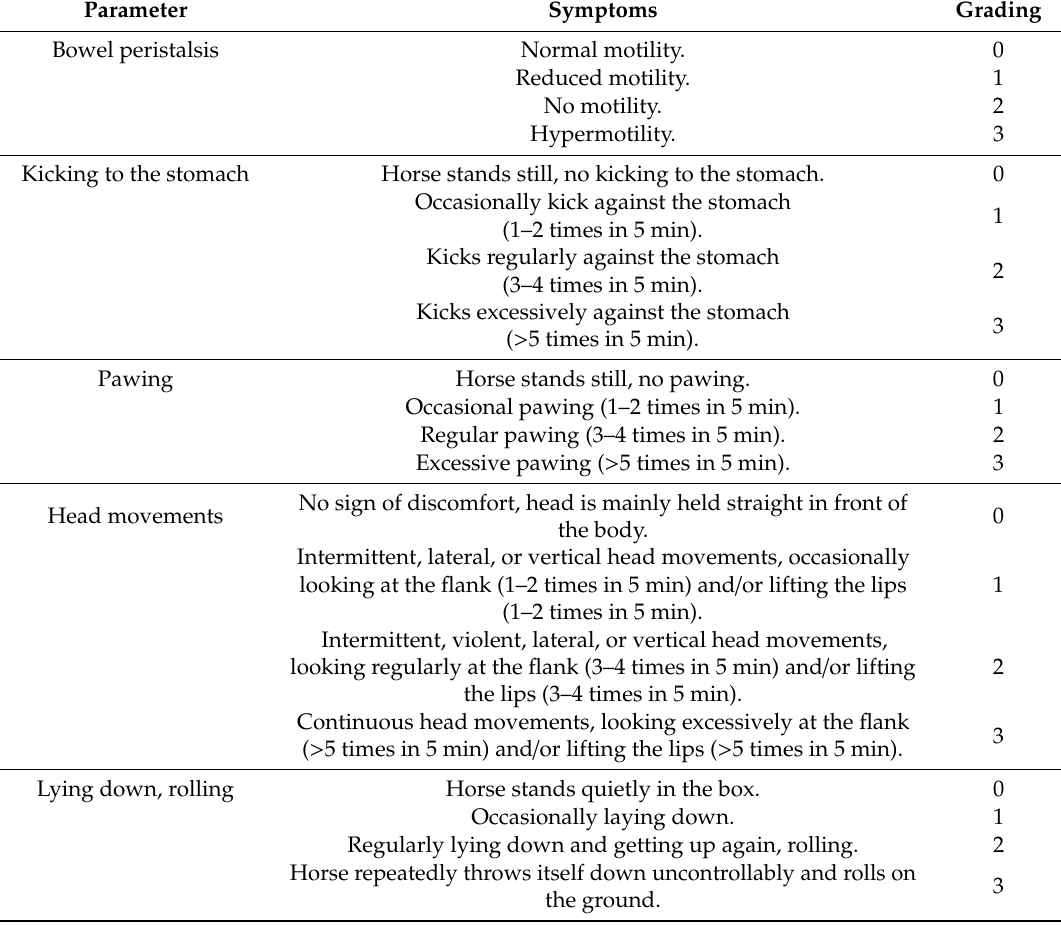
Table 1. Grading of the clinical signs of horses with